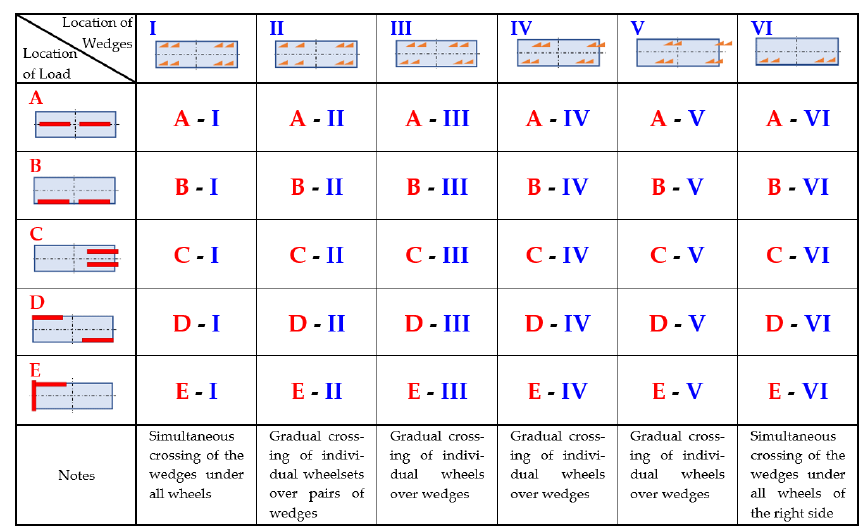
Figure 8. Measured combination of loading and kinematic excitation.